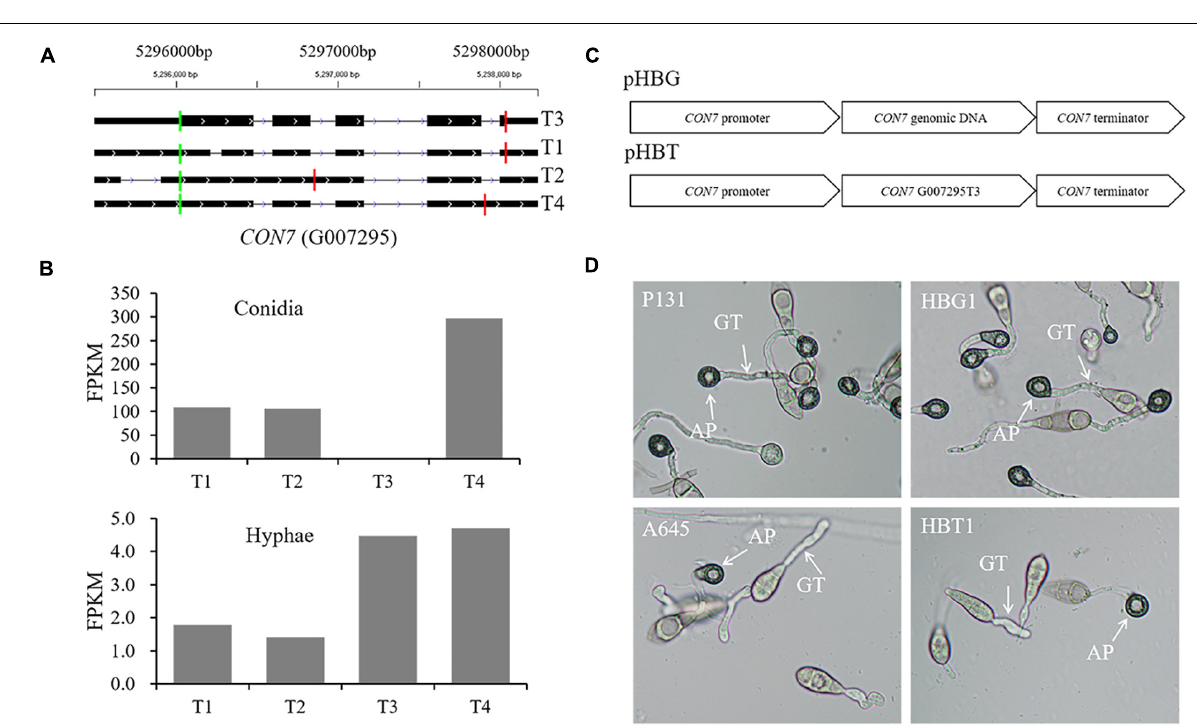
FIGURE 9 | Functional characterization of alternatively spliced transcripts of CON7 . (A) Diagram of four different transcripts of CON7 , T1, T2, T3 (=MGG_05287T0), and T4. Each line meant a transcript of CON7 . Exons are illustrated as black lines, and the thick regions in exons indicate the coding regions. The green and red vertical lines represent translation start and stop sites, respectively. (B) Bar graphs showing the expression levels of the four CON7 transcripts (T1, T2, T3, and T4) in conidia and hyphae. (C) Schematic diagram of pHBG and pHBT vectors. pHBG contains the genomic DNA fragment of CON7 . pHBT contains the transcript G007295T3. pHBG and pHBT were transformed into the A645. (D) Appressorium formation on hydrophobic cover glass slides with conidia of the wild-type strain P131, the con7 insertion mutant A645, strains pHBG and pHBT at 12 hpi. AP, appressorium; GT, germination